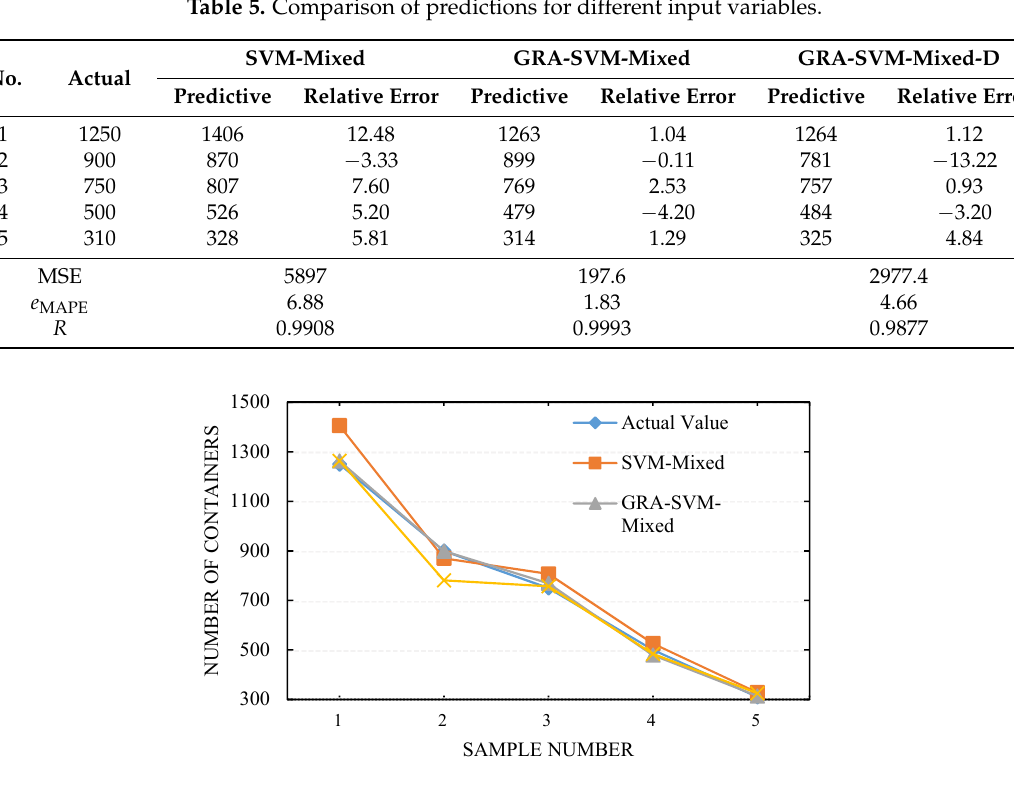
Figure 4. Comparison of values for different input variables.